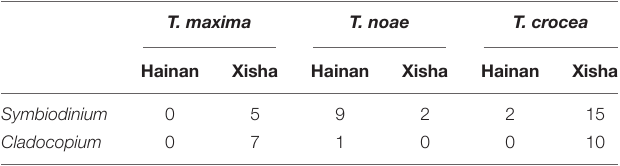
TABLE 3 | Abundance of Tridacna clams with respective endosymbiont genus according to host species and sampling sites. T.